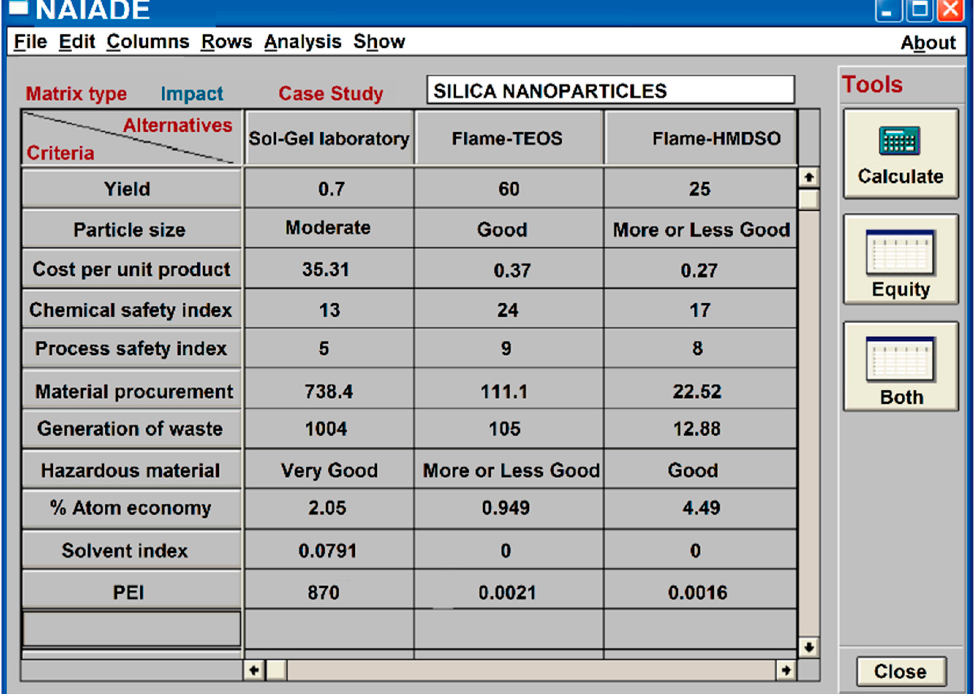
Figure 5. Matrix generated from the NAIADE software. Adapted from Ref. [63].